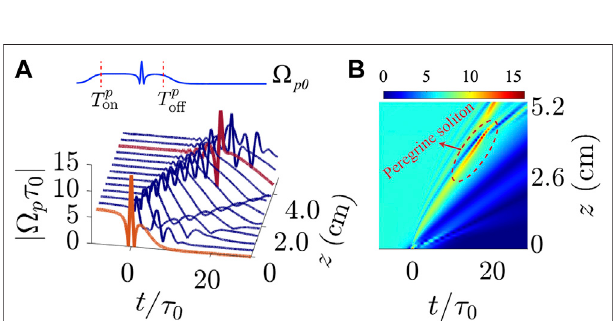
FIGURE 2 | Propagation of ultraslow weak-light Peregrine solitons. (cid:4)(cid:4)(cid:4)(cid:4) (cid:4)(cid:4)(cid:4)(cid:4) τ Ω (A) asafunction of t / τ 0 and z . The solid blue linein the upper part isthe p 0 input temporal shape of the probe fi eld with the dashed vertical lines representingthetemporalboundaries.Theorangelineinthelowerpartis the input Peregrine soliton at z (cid:2) 0. The red line represents the Peregrine solitonpropagatingto z (cid:2) 4 . 3cmwiththemaximumintensity at t (cid:2) 16 . 9 τ 0 (B) The contour map for the propagation of the Peregrine soliton (the red dashed circle) on the t - z plane. The upper color bar shows the intensity of the probe fi